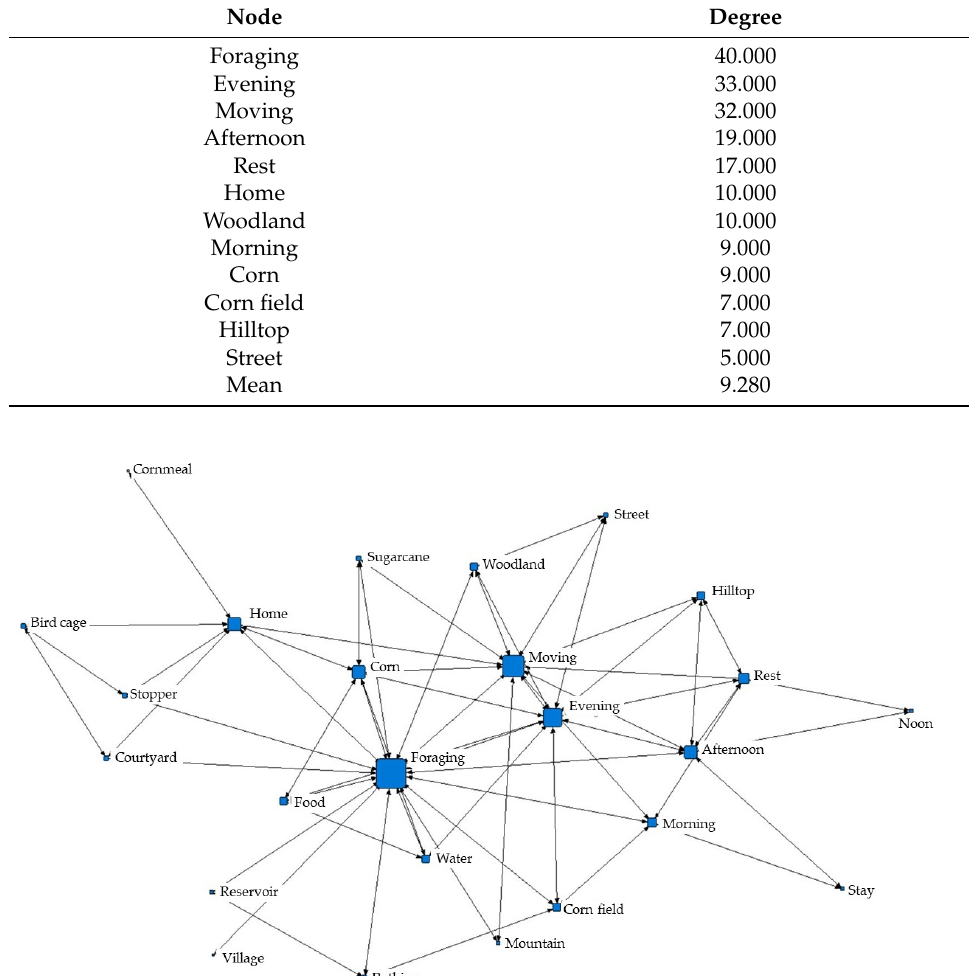
Figure 2. Co-occurrence network of keywords. The points in the figure represent nodes, and the edges represent connections between nodes. The arrow represents the direction of the edge. The larger the node, the stronger the centrality. The closer the words are to the central node core node, the stronger the connection with the central node words.